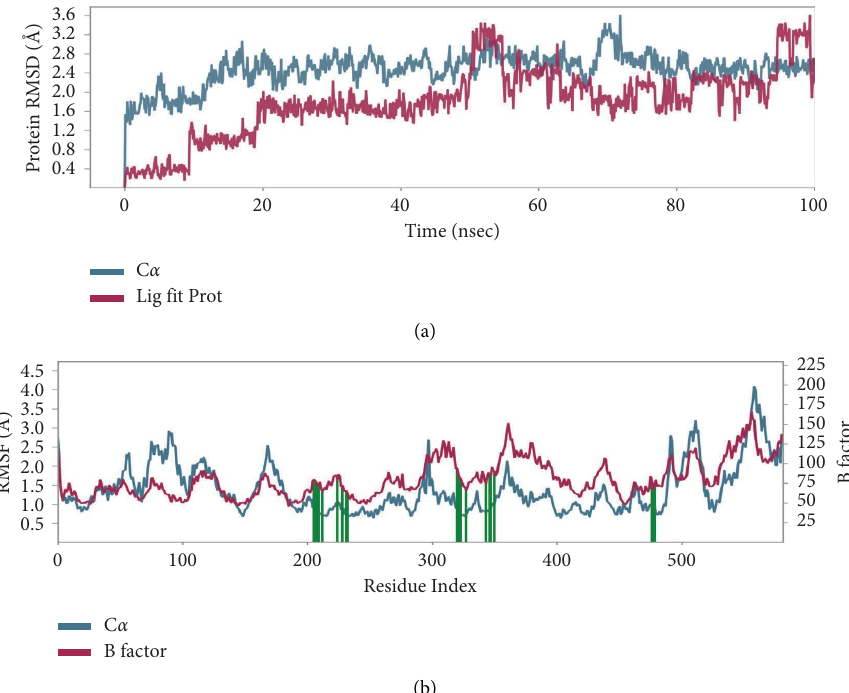
Figure 6: MD simulation of the free BSA and BSA–cuminaldehyde systems. (a) Variation in RMSD over 100ns simulation time, and (b) RMSF of the BSA–cuminaldehyde system compared to crystal structure B-factor. Te vertical green lines on the x -axis represent positions of the amino acid residues that interacted with cuminaldehyde.